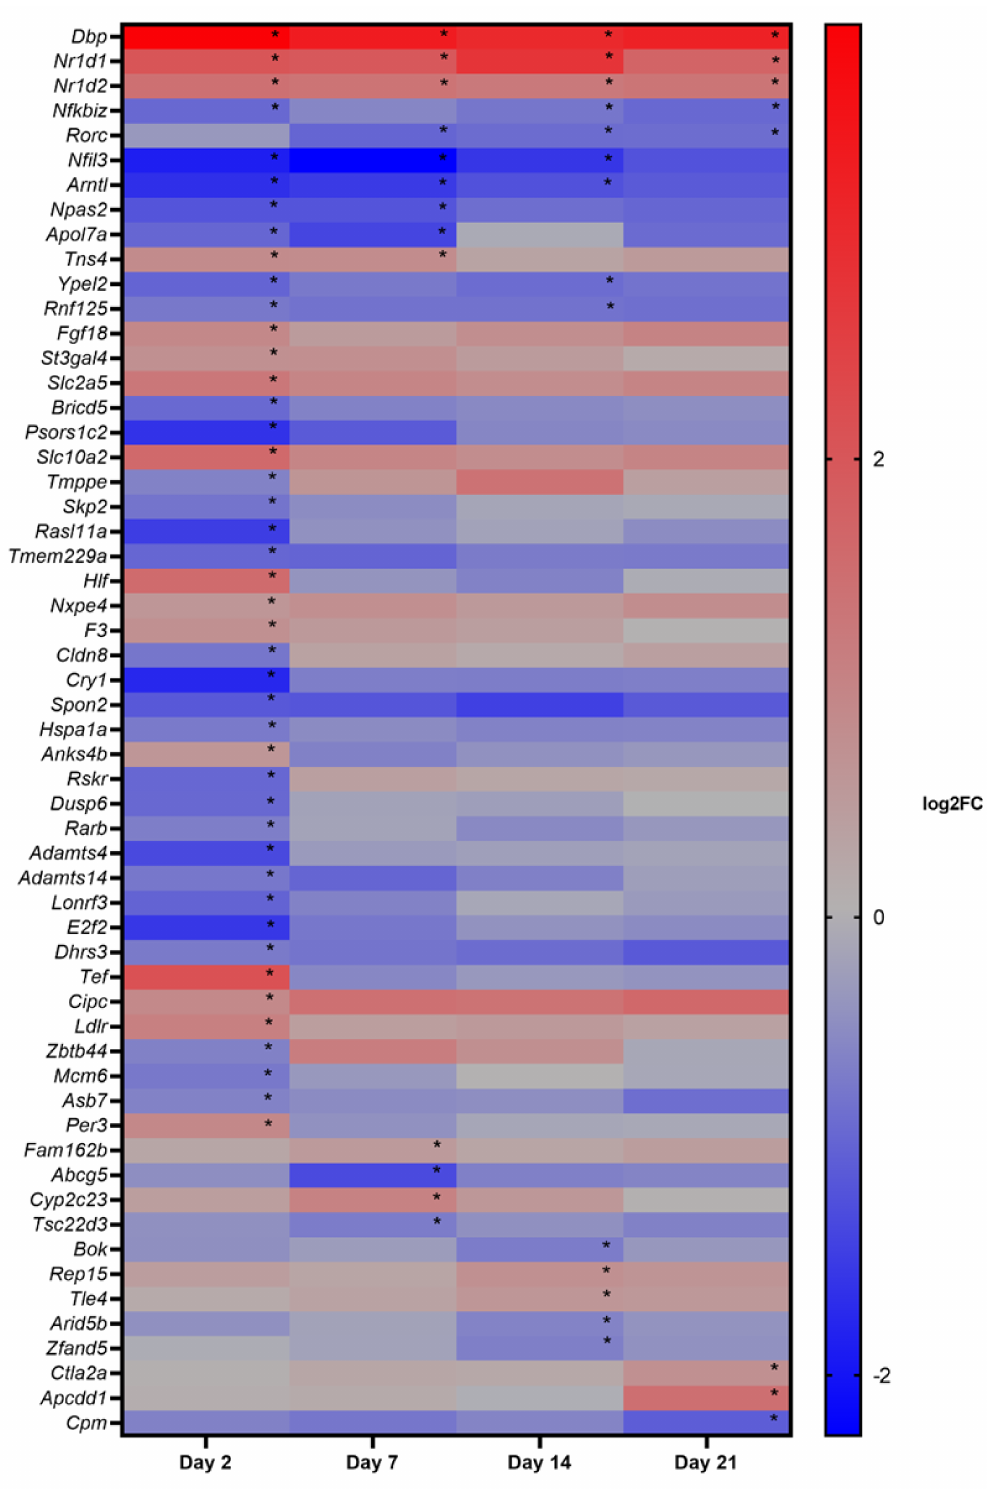
Figure 7. Heatmap of all genes that were differentially expressed (absolute FC ≥ 1.5, q-value < 0.05) at one or more timepoints, following the exposure to 1 mg/kg bw /day of E171. The rows represent the differentially expressed genes, while the columns represent the expression value for the timepoints 2, 7, 14, and 21 days. Red and blue colors indicate the log2FC: red stands for upregulation and blue for downregulation of the gene, in comparison with its time-matched control. The order of genes is based on the number of timepoints a gene was significantly differentially expressed (marked by